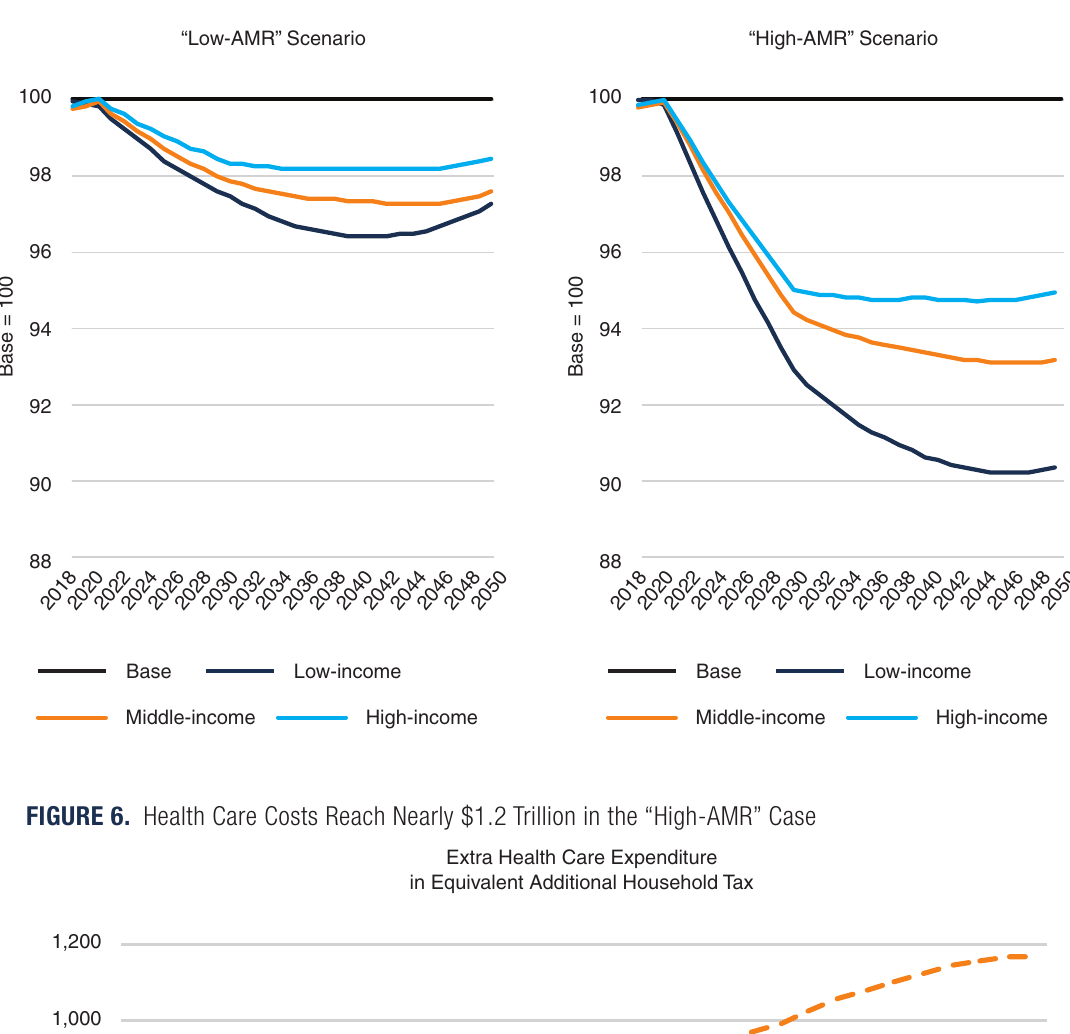
FIGURE 5. Decline in Livestock Production Could Be Substantial and Most Pronounced in Low-Income Countries